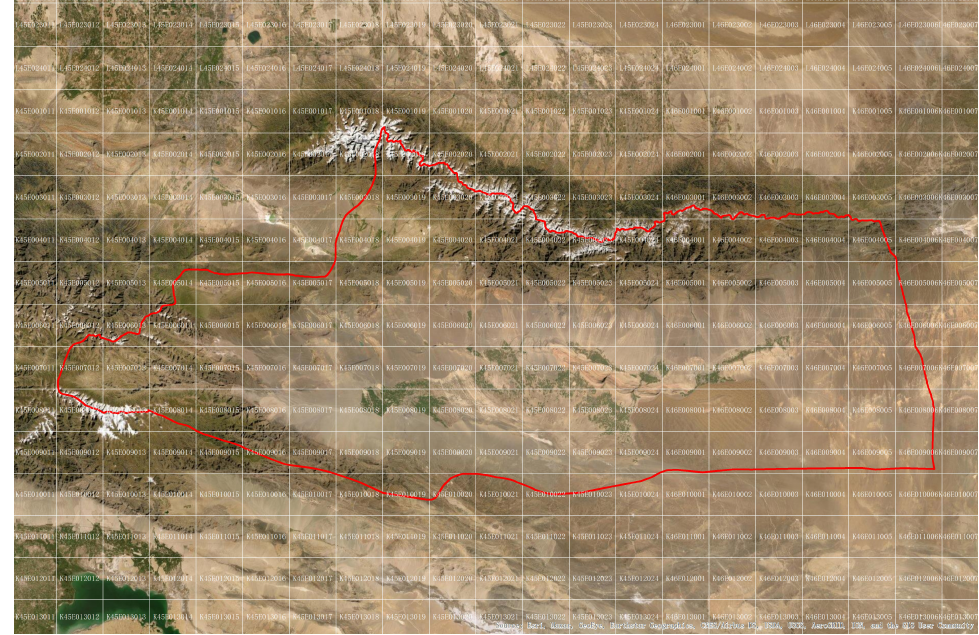
Figure 3. 1:50,000 tile range of Turpan Basin; base map is Esri base map. Through the prediction of karez vertical shafts in 24 maps of Google Earth